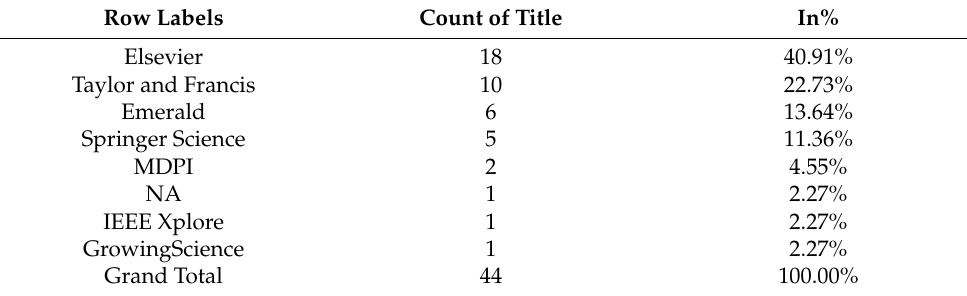
Table 9. Number of SLRs per publisher.